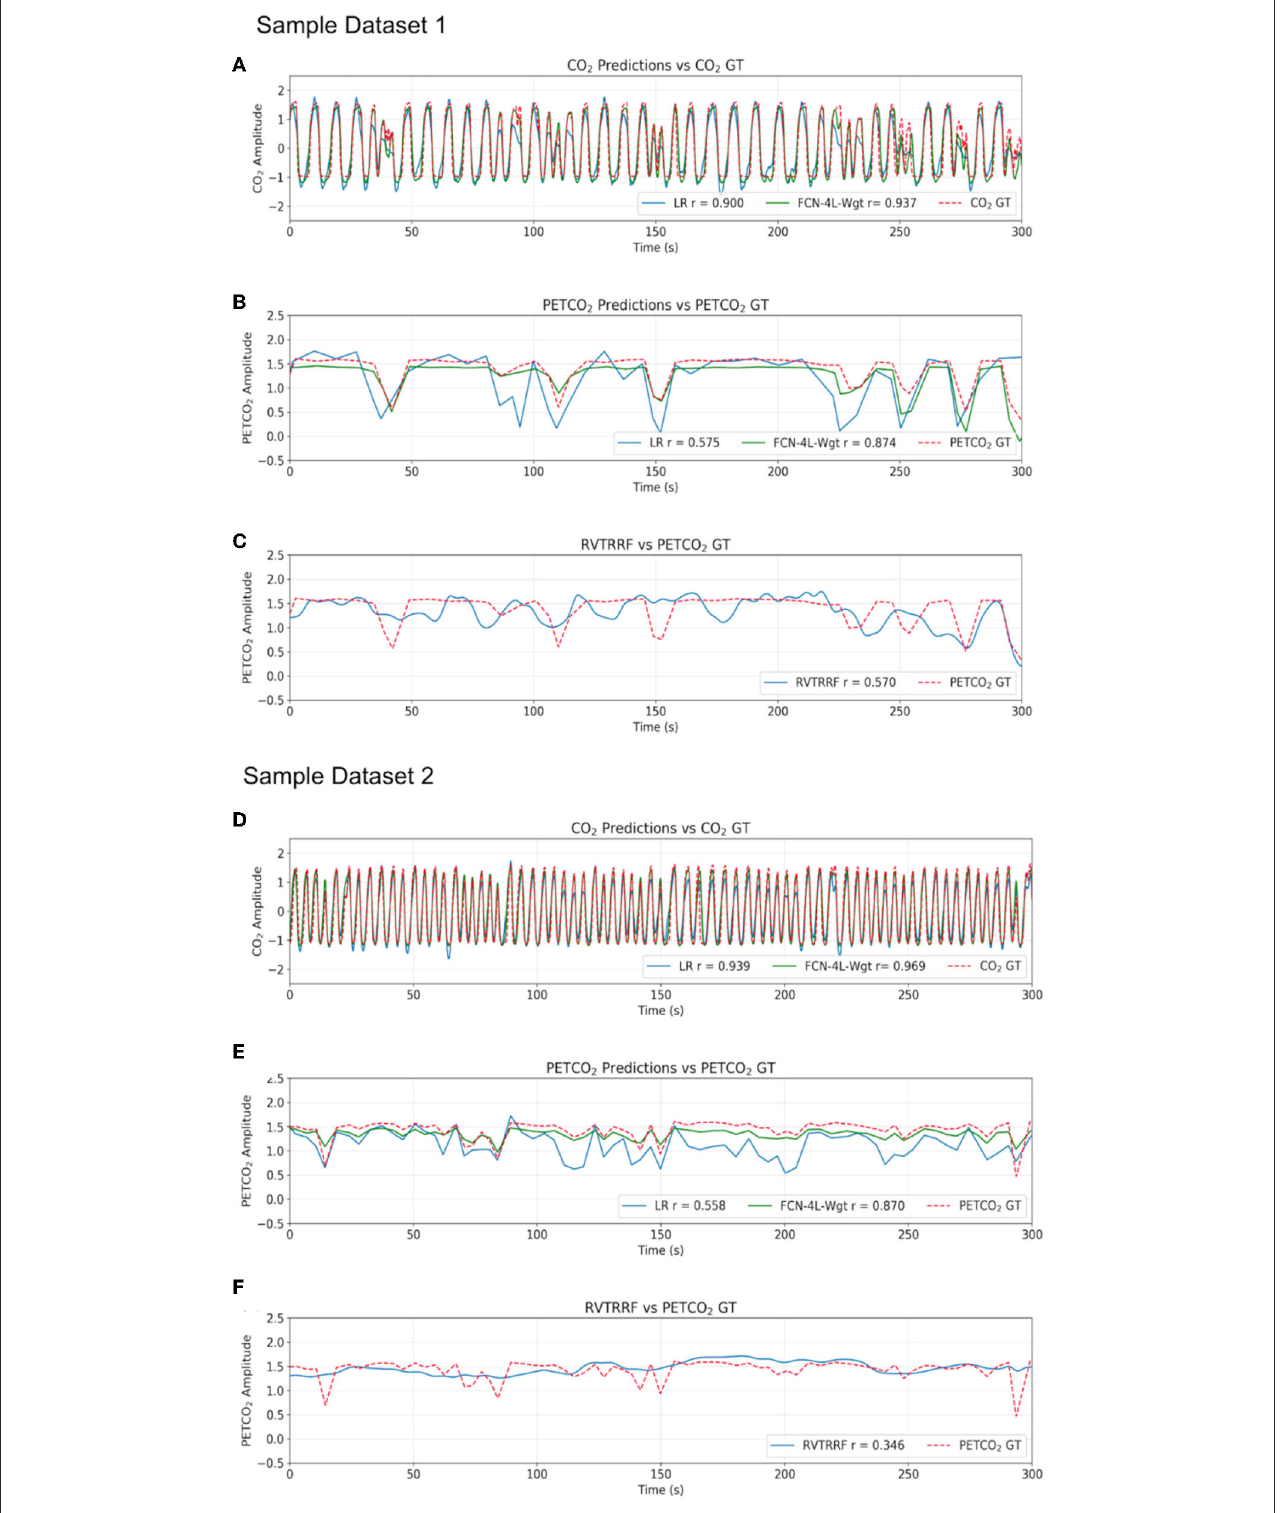
FIGURE4 Qualitative comparison of resultant outputs. Two different sample predictions are shown from the test dataset, and for each of the example, comparisons are made between (A, D) the CO 2 prediction and ground truth (GT), (B, E) the PETCO 2 prediction from the reference linear regression model (LR), FCN-4L-Wgt model and the GT, and (C, F) PETCO 2 estimated from RVTRRF and the PETCO 2